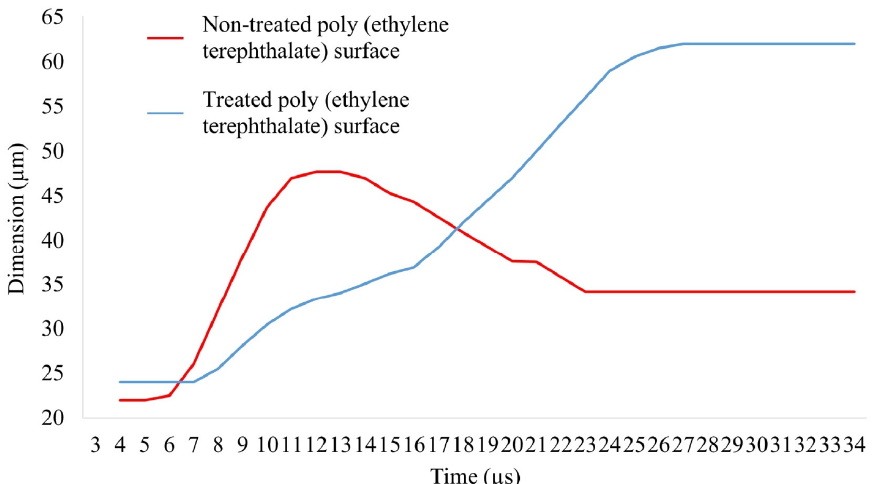
Figure 8. The change in inkjet droplet diameter on the non-treated and treated poly (ethylene terephthalate) surfaces.